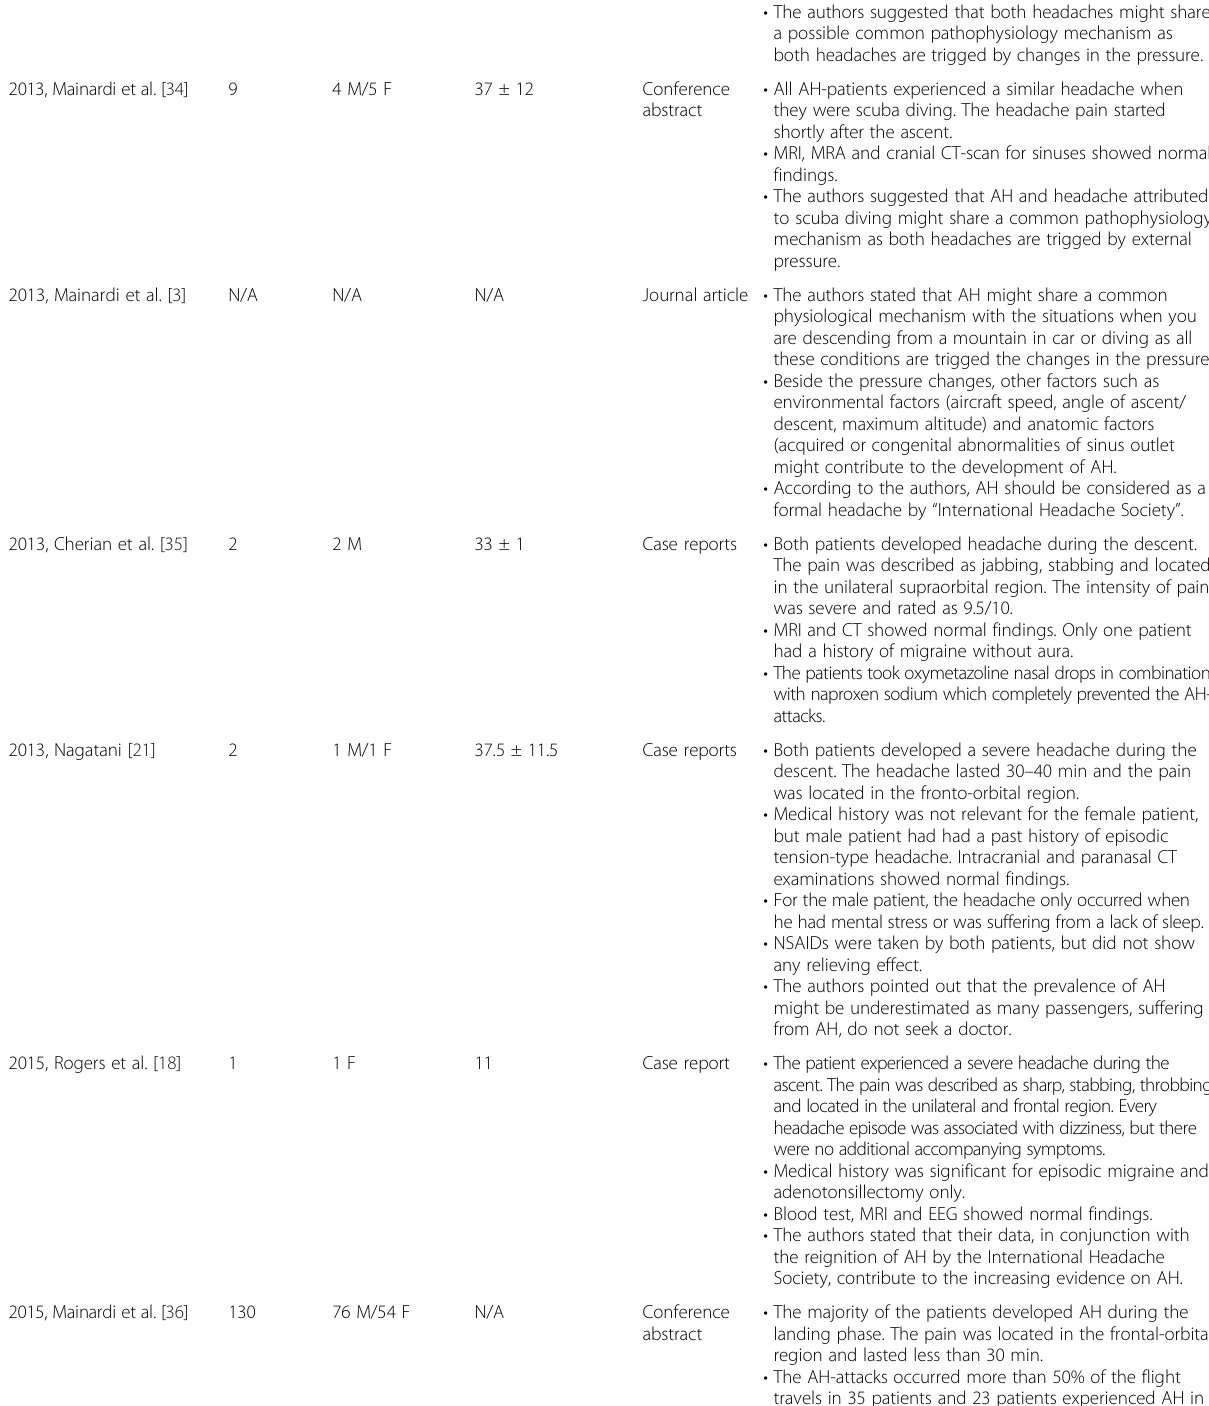
Table 1 Demographic characteristics and main outcomes of the current literature regarding headache attributed to airplane travel (Continued)